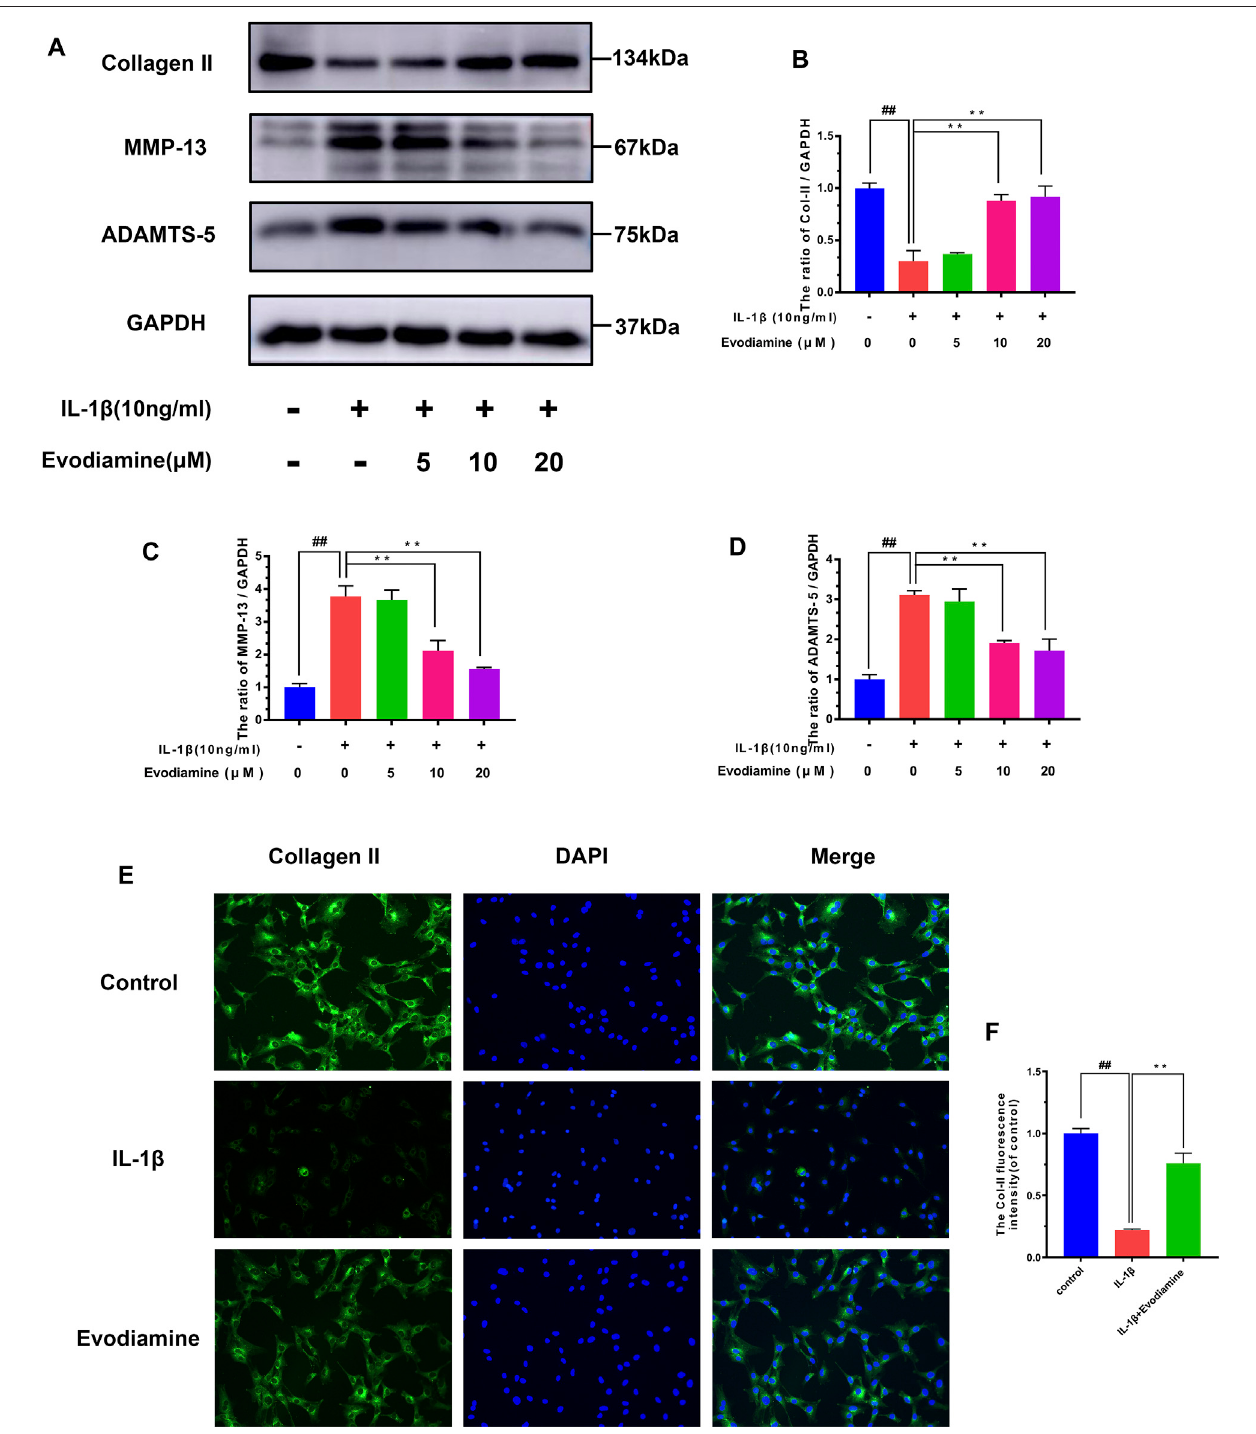
FIGURE 4 | Evodiamine had a protective effect on the ECM degradation of IL-1 β – induced chondrocytes. (A,B,C,D) Relative protein expressions of collagen-II, ADAMTS-5, and MMP-13 were quantitated by Western blot. (E,F) Collagen-II (green) was detected by immuno fl uorescence. Data were expressed as mean ± SD. Signi fi cant differences between different groups are indicated as ## p < 0.01, vs. control group; pp p < 0.01, vs. IL-1 β alone stimulation group, n = 3.